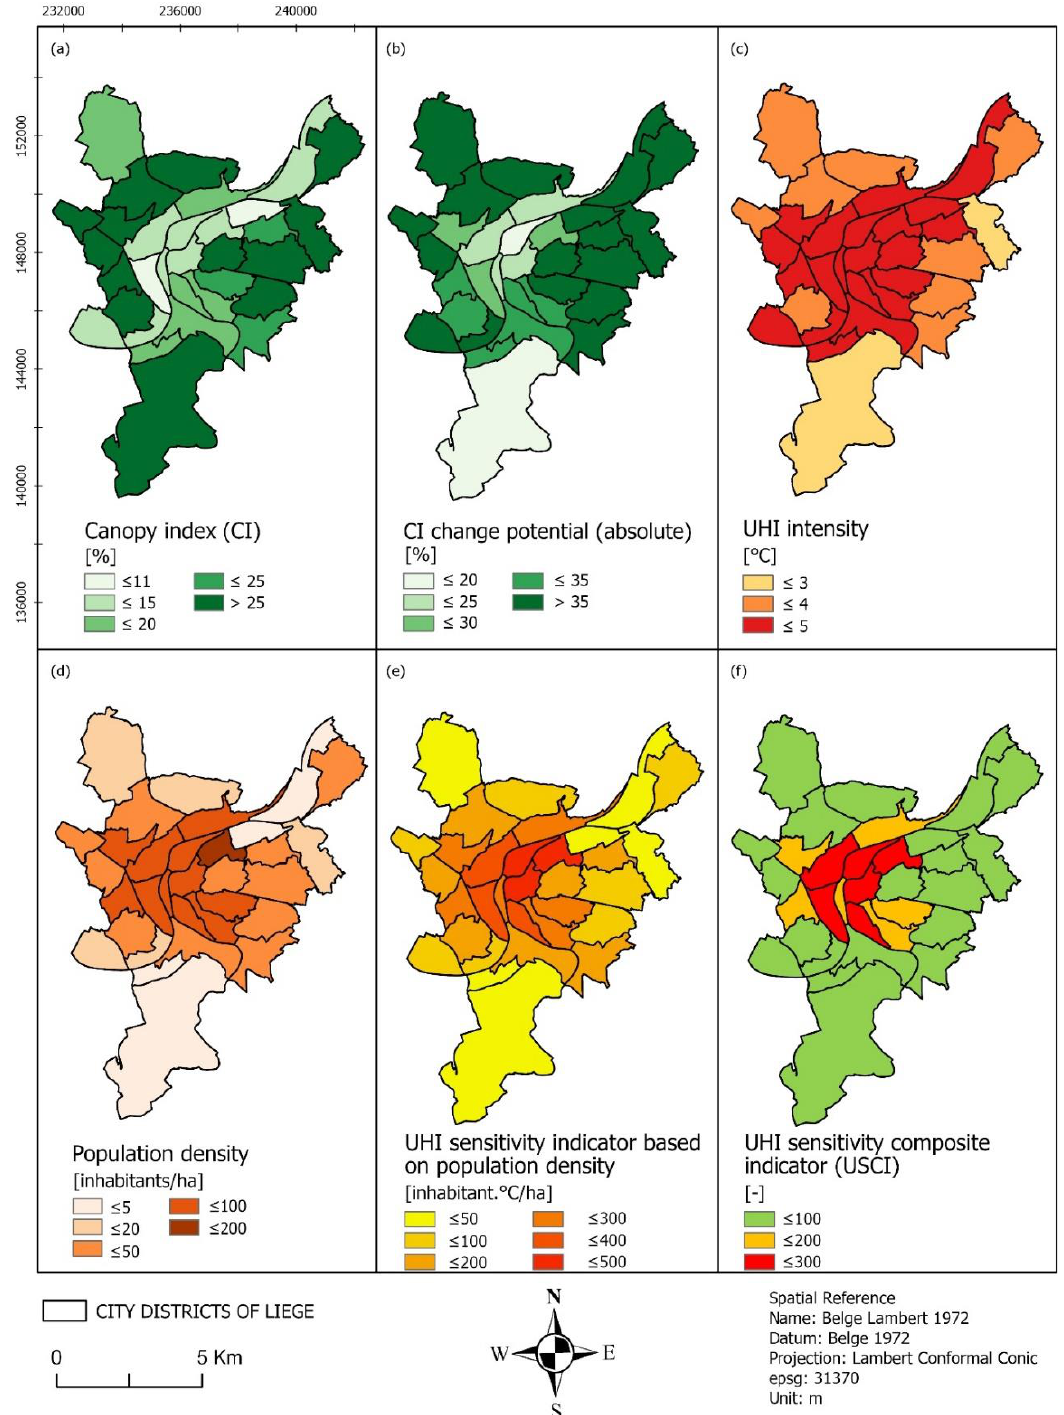
Figure 4. Map analysis by city districts for strategical spatial planning (tree planting) decision based on 2019 data. In total, this scenario highlights the potential for a doubling of the CI at city-scale (from 31.4% to 65.3%) and a significant improvement of CI for each of the city